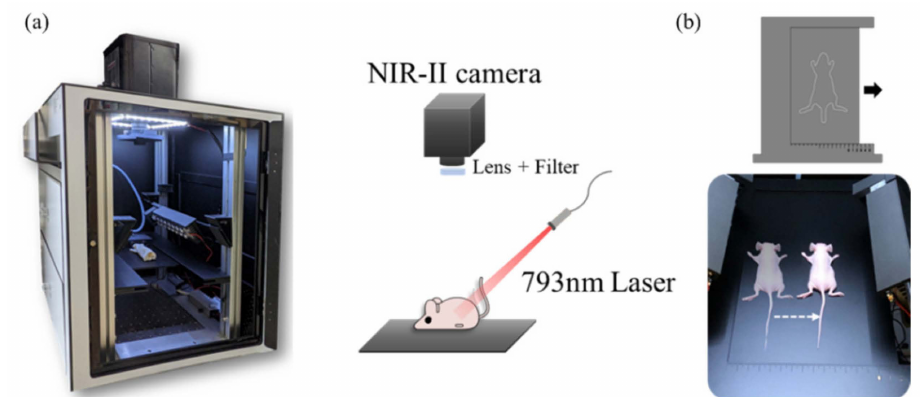
Figure 1. A home-built NIR-II fluorescence stereo imaging setup. ( a ) Photograph and schematic diagram of the epi-illumination NIR-II fluorescence stereo imaging system ( b ) Photograph of the one-dimensional moving stage for mice 3D vasculature